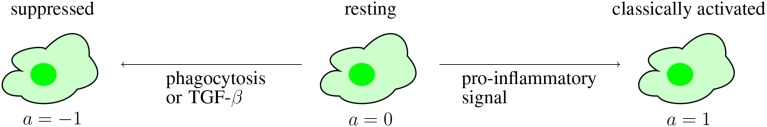
The three states of activation of macrophages in the computational model. Initially, all macrophages are in the resting state. During the course of infection, some pass to a suppressed state, due to phagocytosis or the effect of TGF-β. Others are activated by the effect of pro-inflammatory signals, from DAMP or IFN-γ.